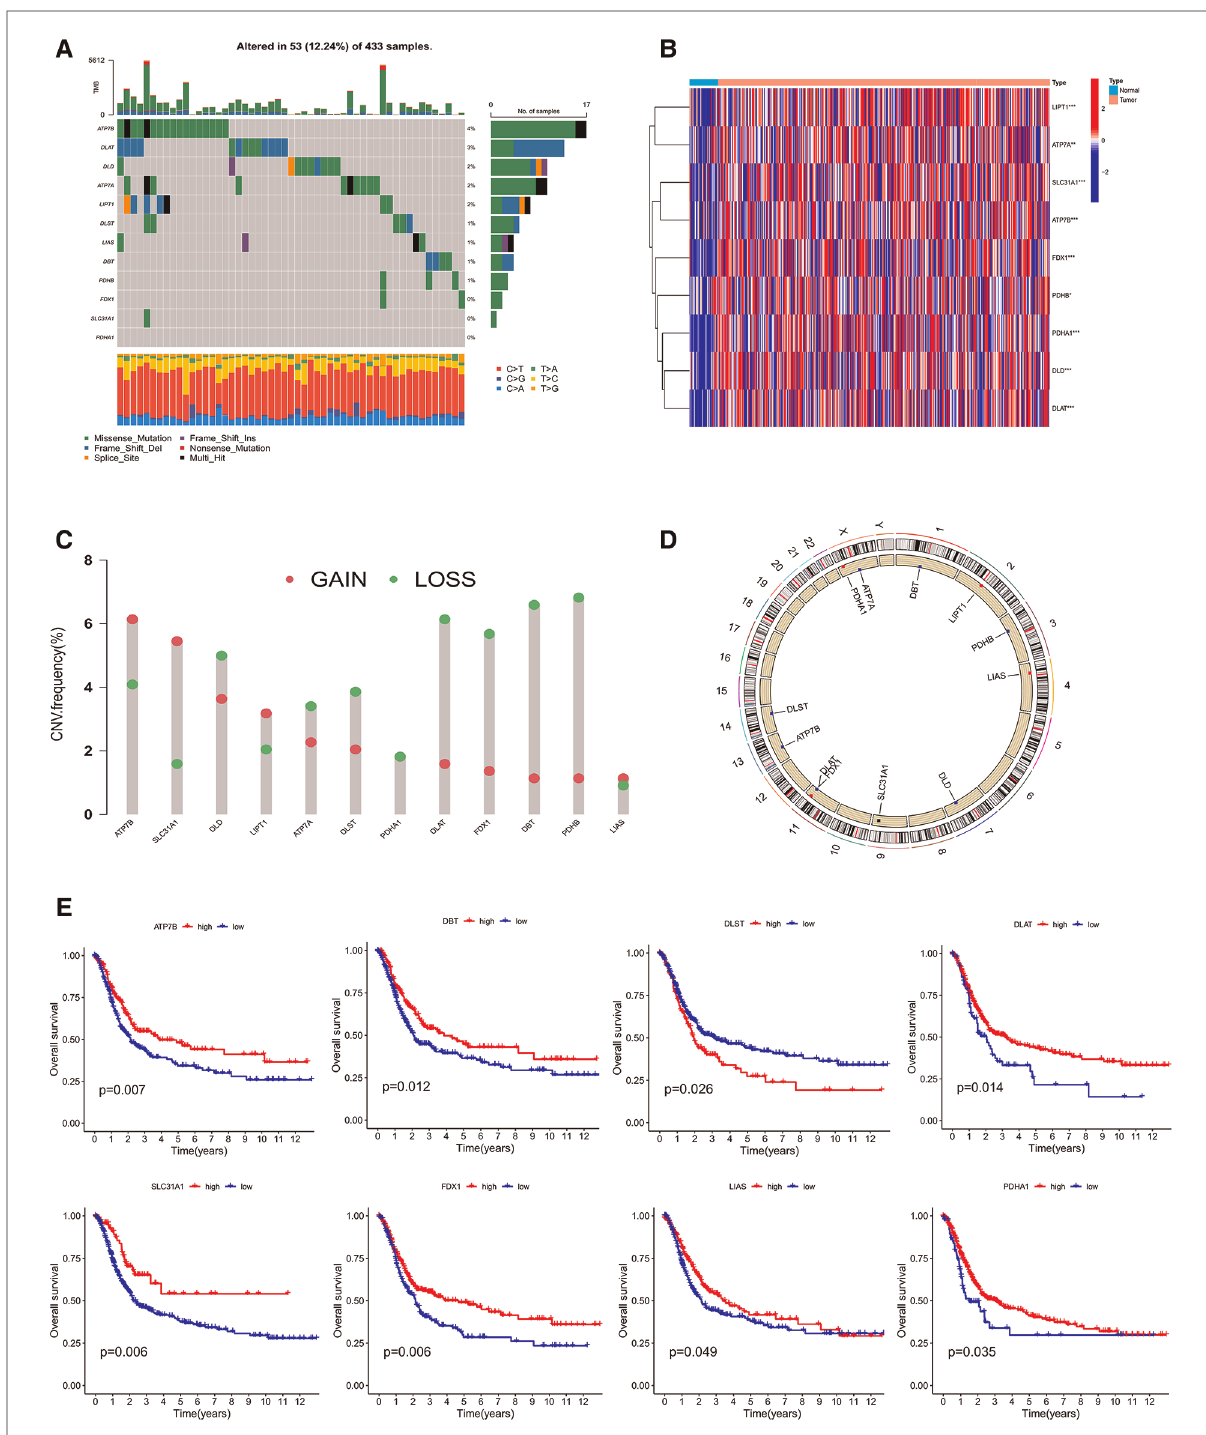
FIGURE 2 ( A ) mutation characteristic of 12 CRGs from TCGA. ( B ) The expression of CRGs between Normal and tumor. ( C,D ) The changes of somatic copy number variation in CRGs. ( E ) The survival analysis of CRGs. CRGs, cuprotosis-related genes. (* P <0.05; ** P <0.01; *** P <0.001; ns, not signi fi